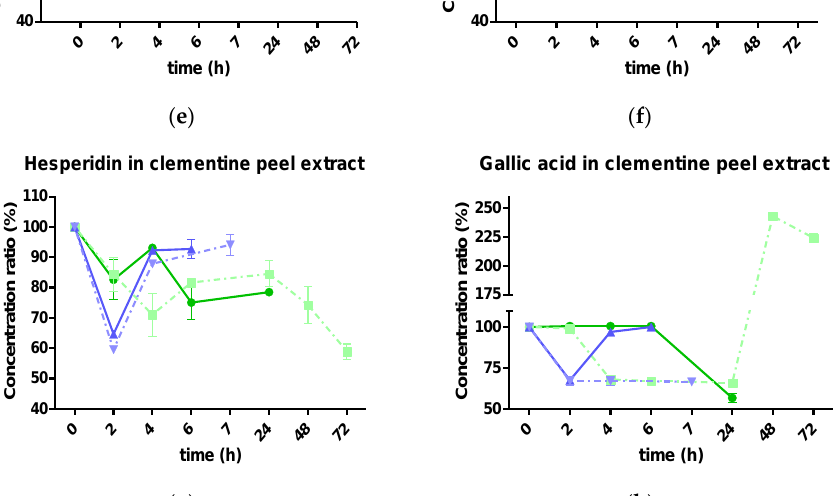
Figure 3. Stability of the individual polyphenols monitored in lemon peel extract ( a – d ) and clementine peel extract ( e – h ) under different drying